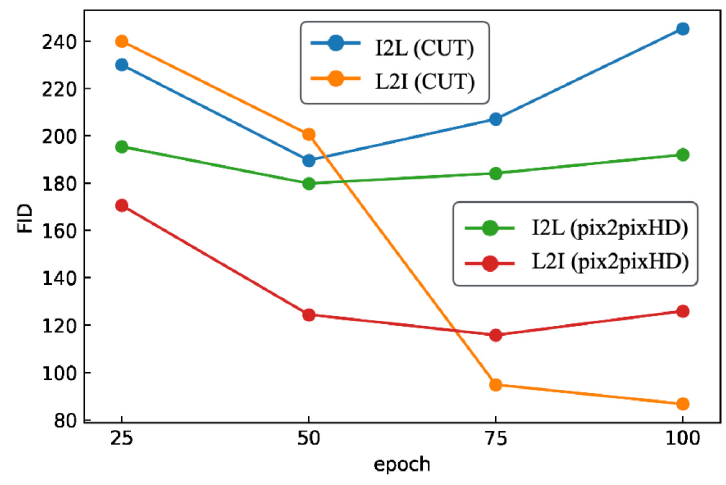
Figure 13. Time-series FID trends for the respective GANs in